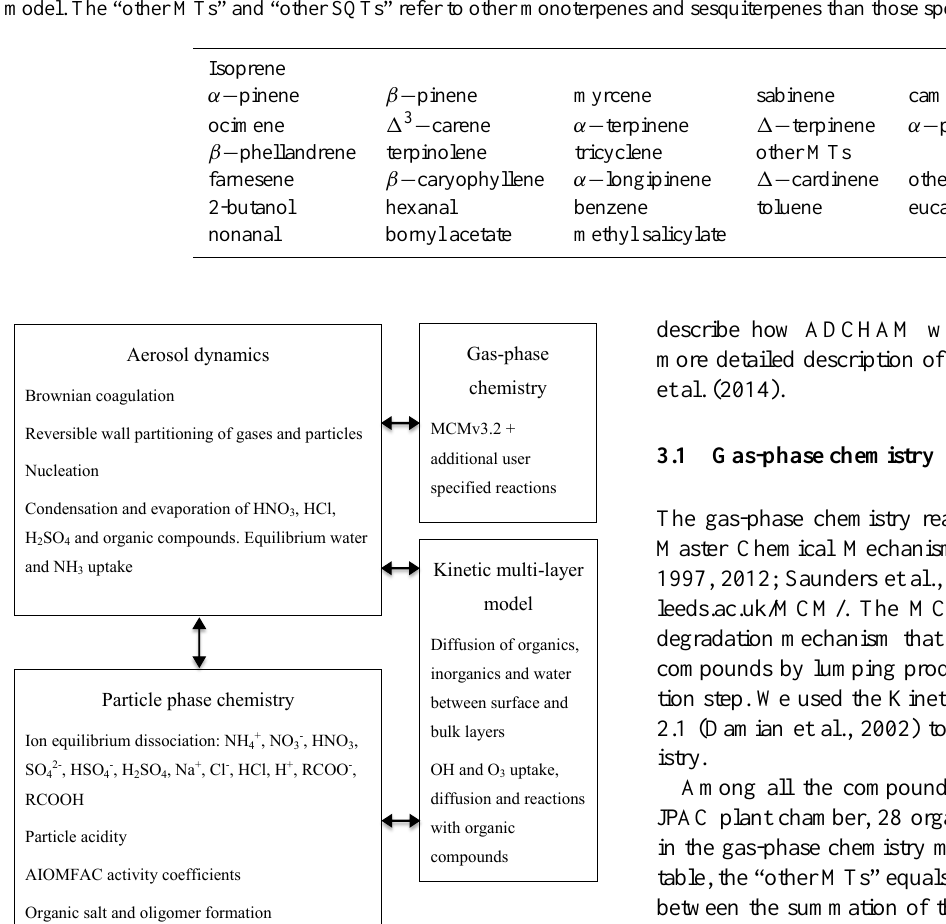
Table 1. The VOCs measured with GC-MS in the JPAC plant chamber. The measured concentrations were used as input for the ADCHAM model. The “other MTs” and “other SQTs” refer to other monoterpenes and sesquiterpenes than those specified in the table, respectively.